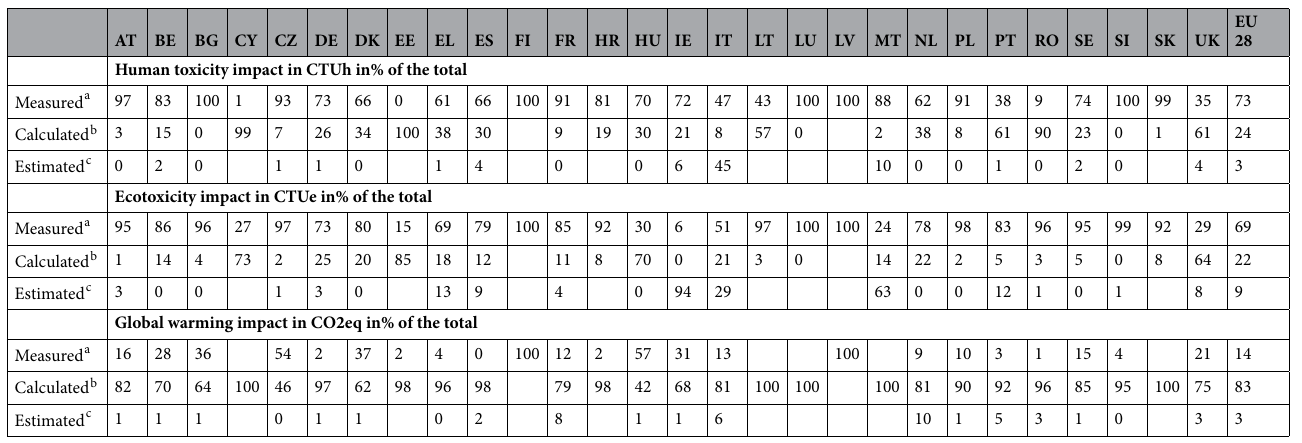
Table 6. Shares of measured, calculated and estimated pollutant releases in% of total impact potentials by country (2017) a ‘Measured’ : “M” is reported when the releases of a facility are derived from direct monitoring results for specific processes at the facility, based on actual continuous or discontinuous measurements of pollutant concentrations for a given release route. b ‘Calculated’ : “C” is reported when the releases are